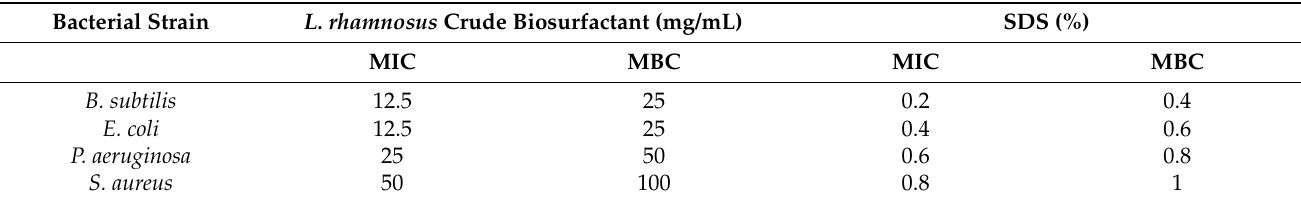
Figure 3. Results of the antibacterial, antibiofilm and anti-adhesion activity of the L. rhamnosus crude biosurfactant and standard SDS. ( A ) Antibacterial activity of the L. rhamnosus crude biosurfactant (100 mg/mL) and standard SDS surfactant (1% v / v ) against different bacterial pathogens. ( B ) Effect of the L. rhamnosus crude biosurfactant and standard SDS surfactant on established biofilms of different bacterial pathogens at their respective MICs. ( C ) Effect of the L. rhamnosus crude biosurfactant and standard SDS surfactant on the adherence ability of different bacterial pathogens at their respective MICs. Values are the mean ± SD of three independent experiments. Table 2. Antibacterial activity of the L. rhamnosus crude biosurfactant and standard SDS. Bacterial